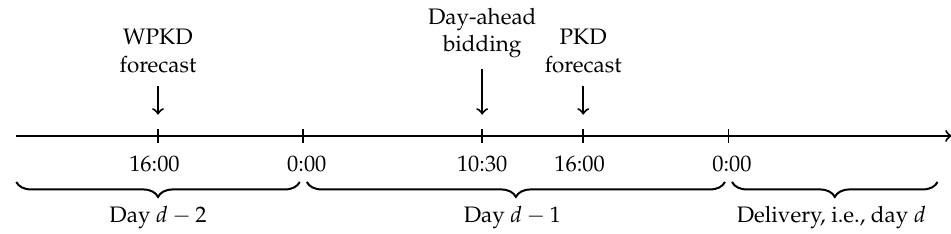
Figure 3. The timeline of country-wide wind generation forecasts published by PSE S.A. and trading activity in the Polish market. See text for